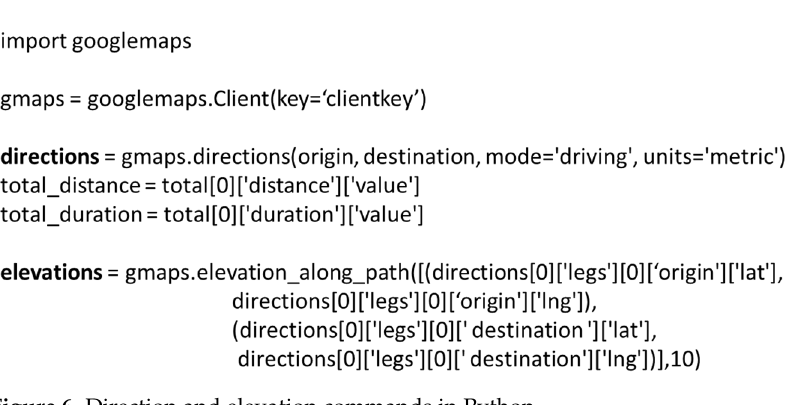
Figure 6. Direction and elevation commands in